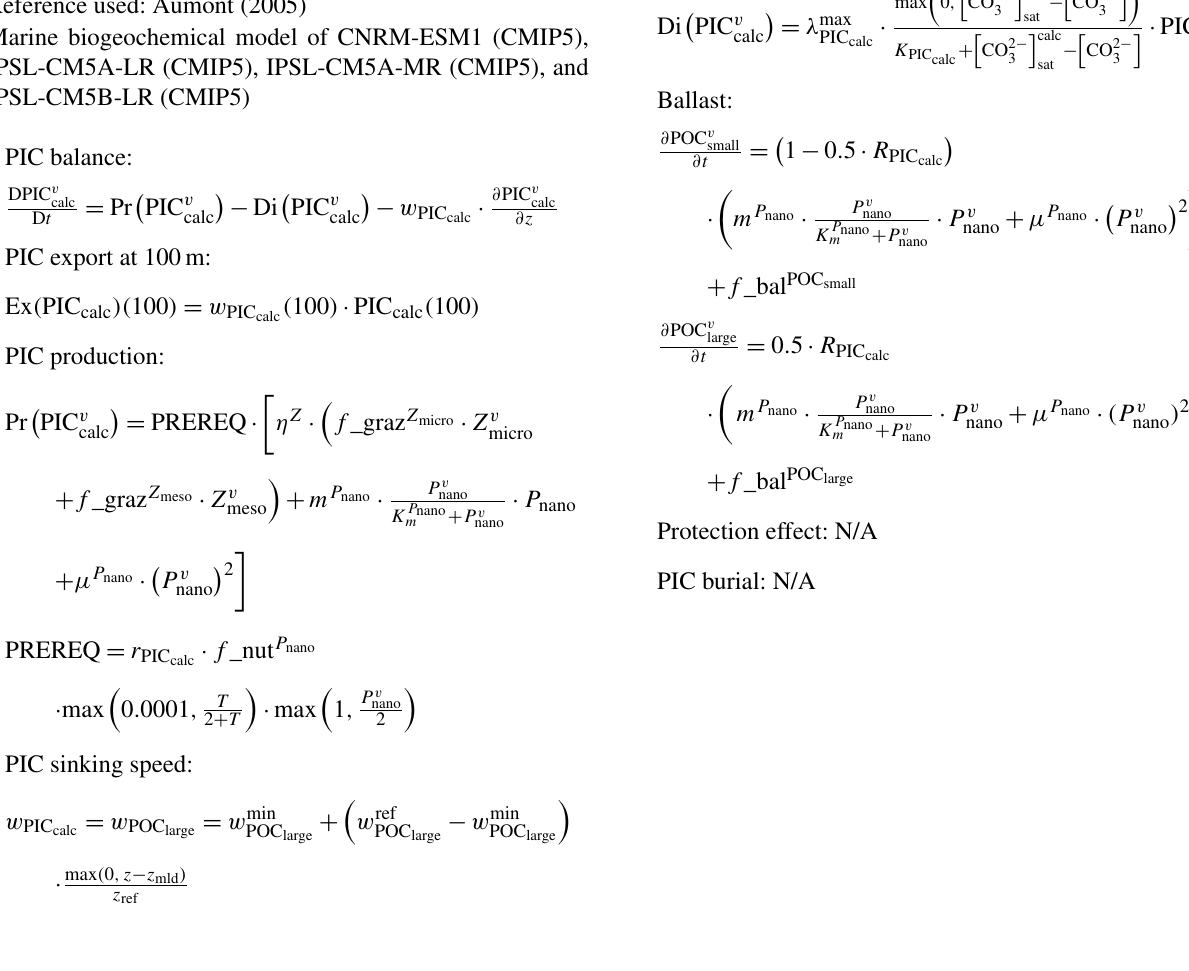
Table C5. PISCESv1